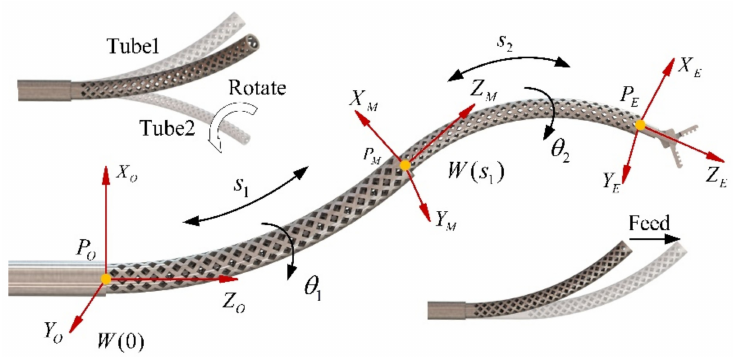
Figure 2. Coordinate system